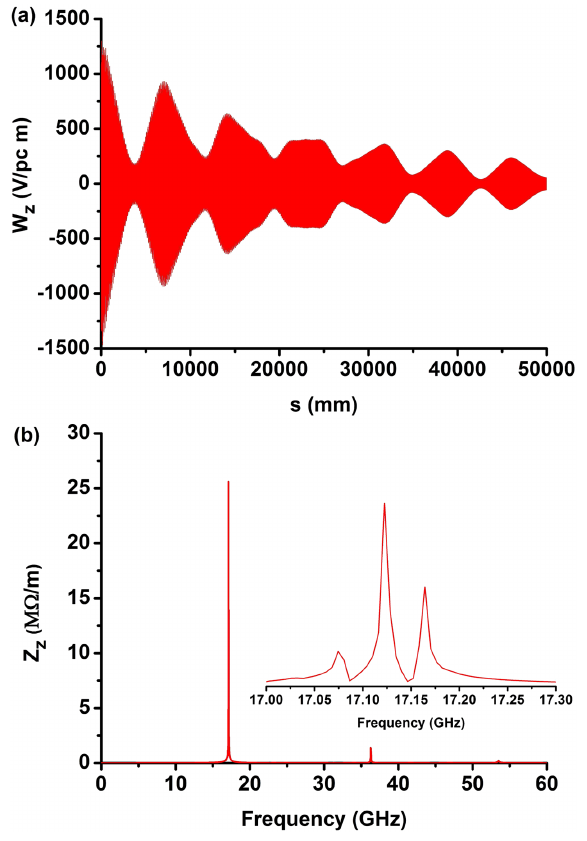
FIG. 2. Calculation of longitudinal wake potential and imped- ance: (a) longitudinal wake potential on a line parallel to the structure centerline and displaced 0.8 mm in the x direction, i.e., following the path of the beam; (b) longitudinal wake potential impedance.